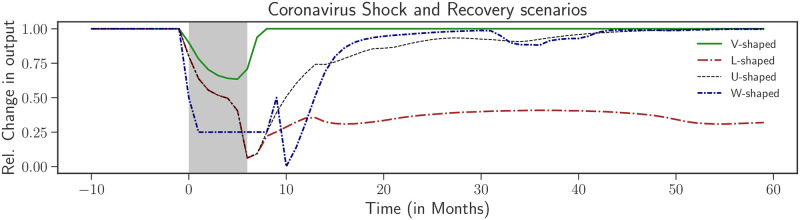
Possible recovery patterns following the coronavirus shock, which starts at time t = 0.We show, as a function of time, the fall in output relative to the no-shock scenario. For mild shocks (Δc/c = 0.3, Δζ/ζ = 0.1, lasting six months), the economy contracts but quickly recovers (V-Shaped recovery). For more severe shocks over the same time period (Δc/c = 0.3, Δζ/ζ = 0.2), the economy contracts permanently and never recovers (at least on the time scale of the simulation). This is the dreaded L-shaped scenario, in the absence of any government policy. An increase in consumption propensity to c = 0.7 (0.2 above pre-crisis levels) and a helicopter money drop at the end of the shock leads to a faster recovery (U-shaped recovery). Finally, a W-shaped scenario, with a second downturn occurring 30 months after the initial shock, can also be found for stronger shocks (Δc/c = 0.3, Δζ/ζ = 0.5, lasting nine months) with strong government policy and a helicopter drop.